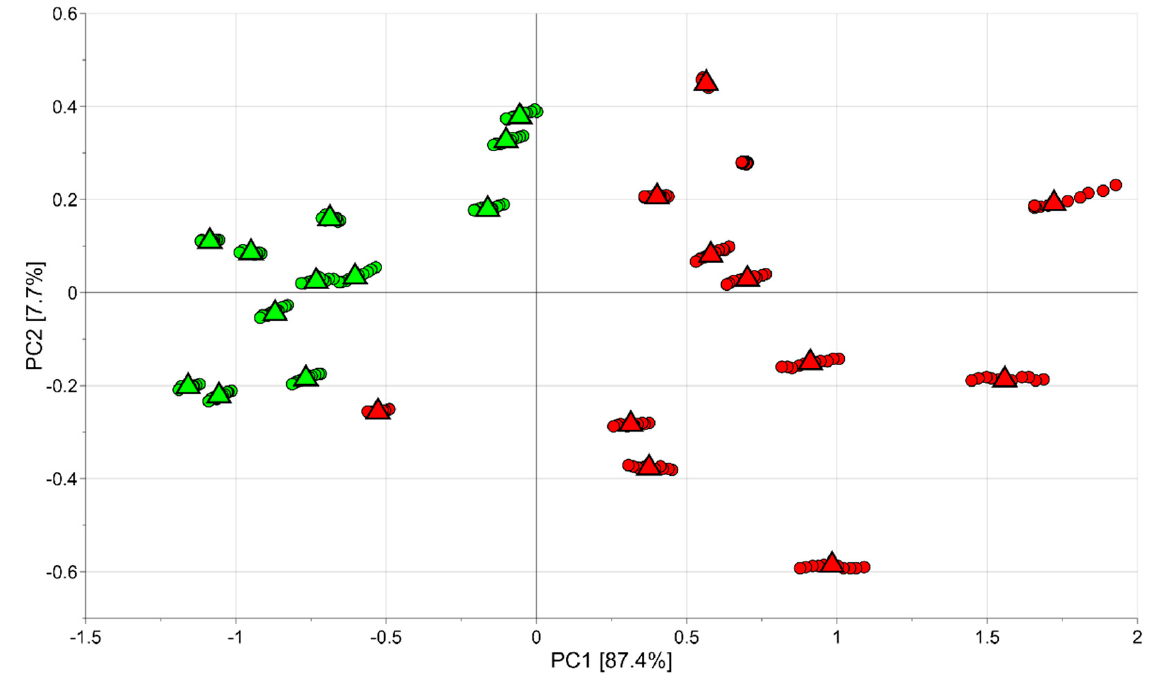
Figure 1. PCA model of the e-nose data: circles represent the observations (technical replicates), while triangles indicate the medians of the technical replicates of the same sample; the green colour is used for observations belonging to the half-red group and the red colour for those of the red group.